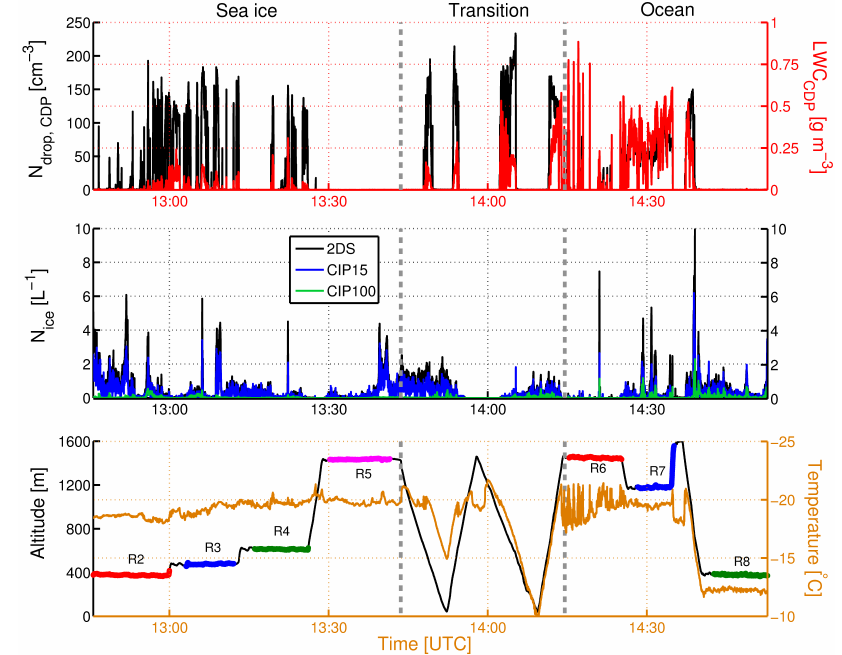
Figure 5. Time series of data collected during the science period of ACCACIA flight B762. Top: CDP droplet number concentration (black) and derived liquid water content (red). Middle: 2DS (black), CIP15 (blue), and CIP100 (green) ice number concentration. Bottom: GPS altitude (black), with individual SLRs noted in colour, and temperature measured by the Rosemount de-iced temperature sensor (orange). SLR colours relate to data shown in Figs. 6 and 9. Sea ice, transition, and ocean regions are indicated above the top